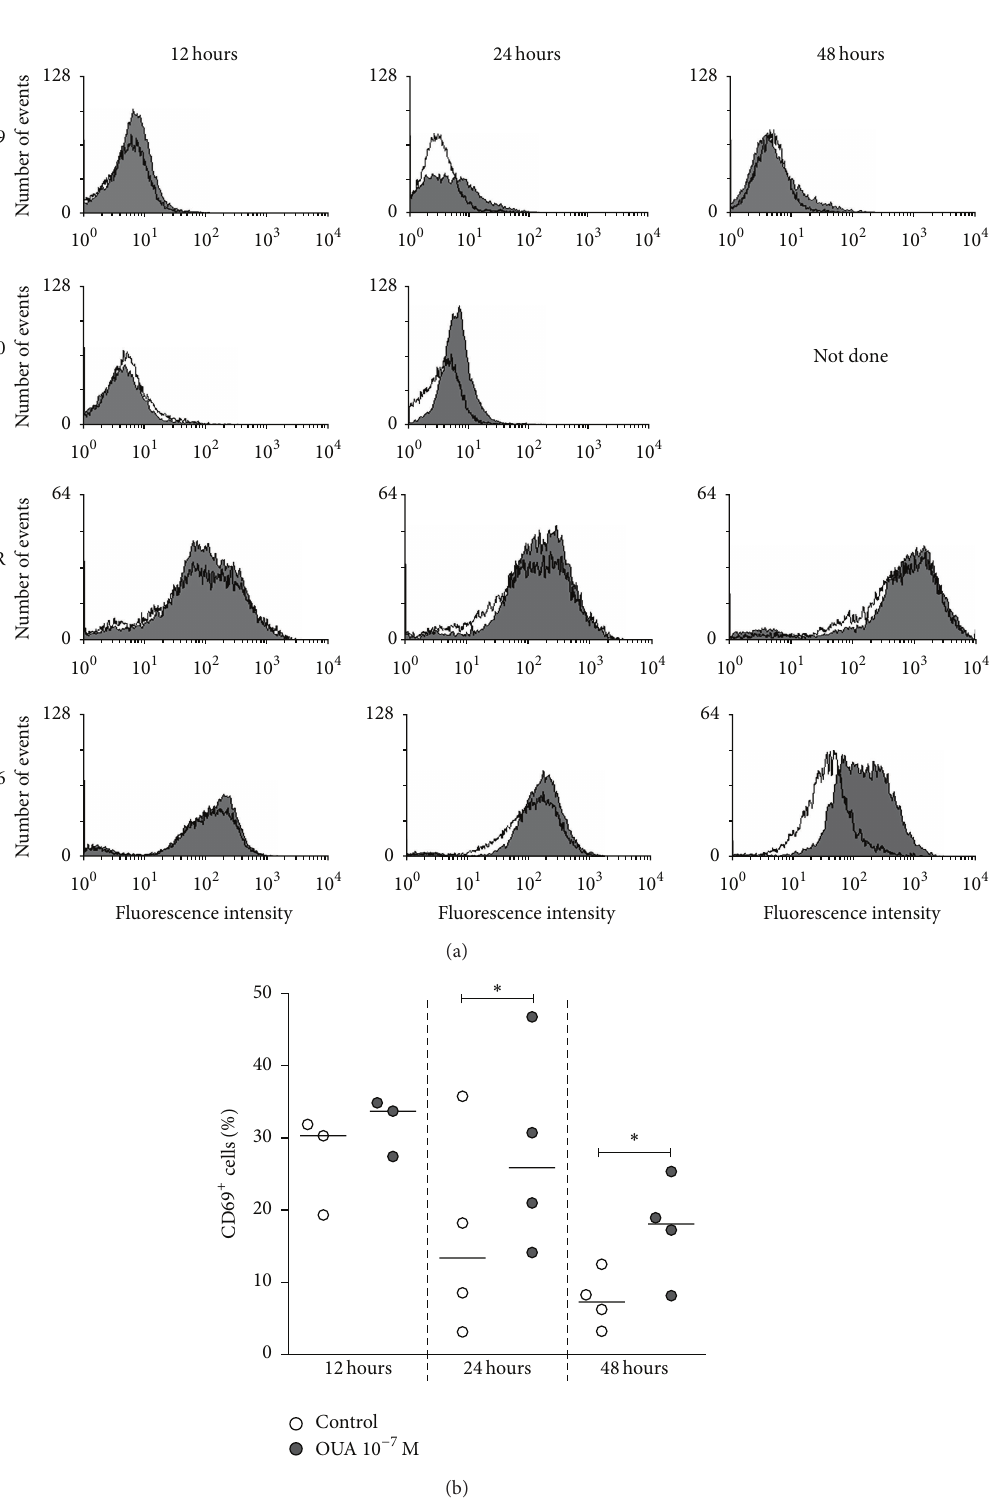
Figure 3: Time course of ouabain effect over the expression of activation and costimulatory molecules by monocytes. Cells were labeled with specific antibodies for 30 minutes (see Section 2) after 12, 24, and 48 hours of culture in the absence or presence of 10 −7 M of ouabain. (a) HistogramsshowingthepatternsofCD69,CD80,HLA-DR,andCD86expressiononmonocytesuntreated(emptyhistograms)ortreatedwith 10 −7 M of ouabain (gray histograms) for 12, 24, and 48 hours. 24 hours, 𝑛 ≥ 6 ; 12 and 48 hours, 𝑛 = 1 , with the exception of CD69 experiments ( 𝑛 ≥ 3 ). (b) Data are expressed as the percentage of CD69 + monocytes and lines refer to the median of three (12-hour experiments) or four (24- and 48-hour experiments) independent measurements from distinct individuals. ∗ 𝑃 < 0.05 using two-tailed paired t